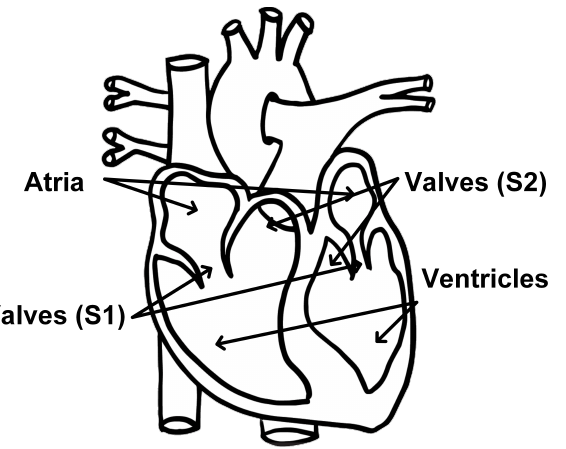
Figure 2. Diagram of heart components associated with the first and second heart sounds identified. Modified from